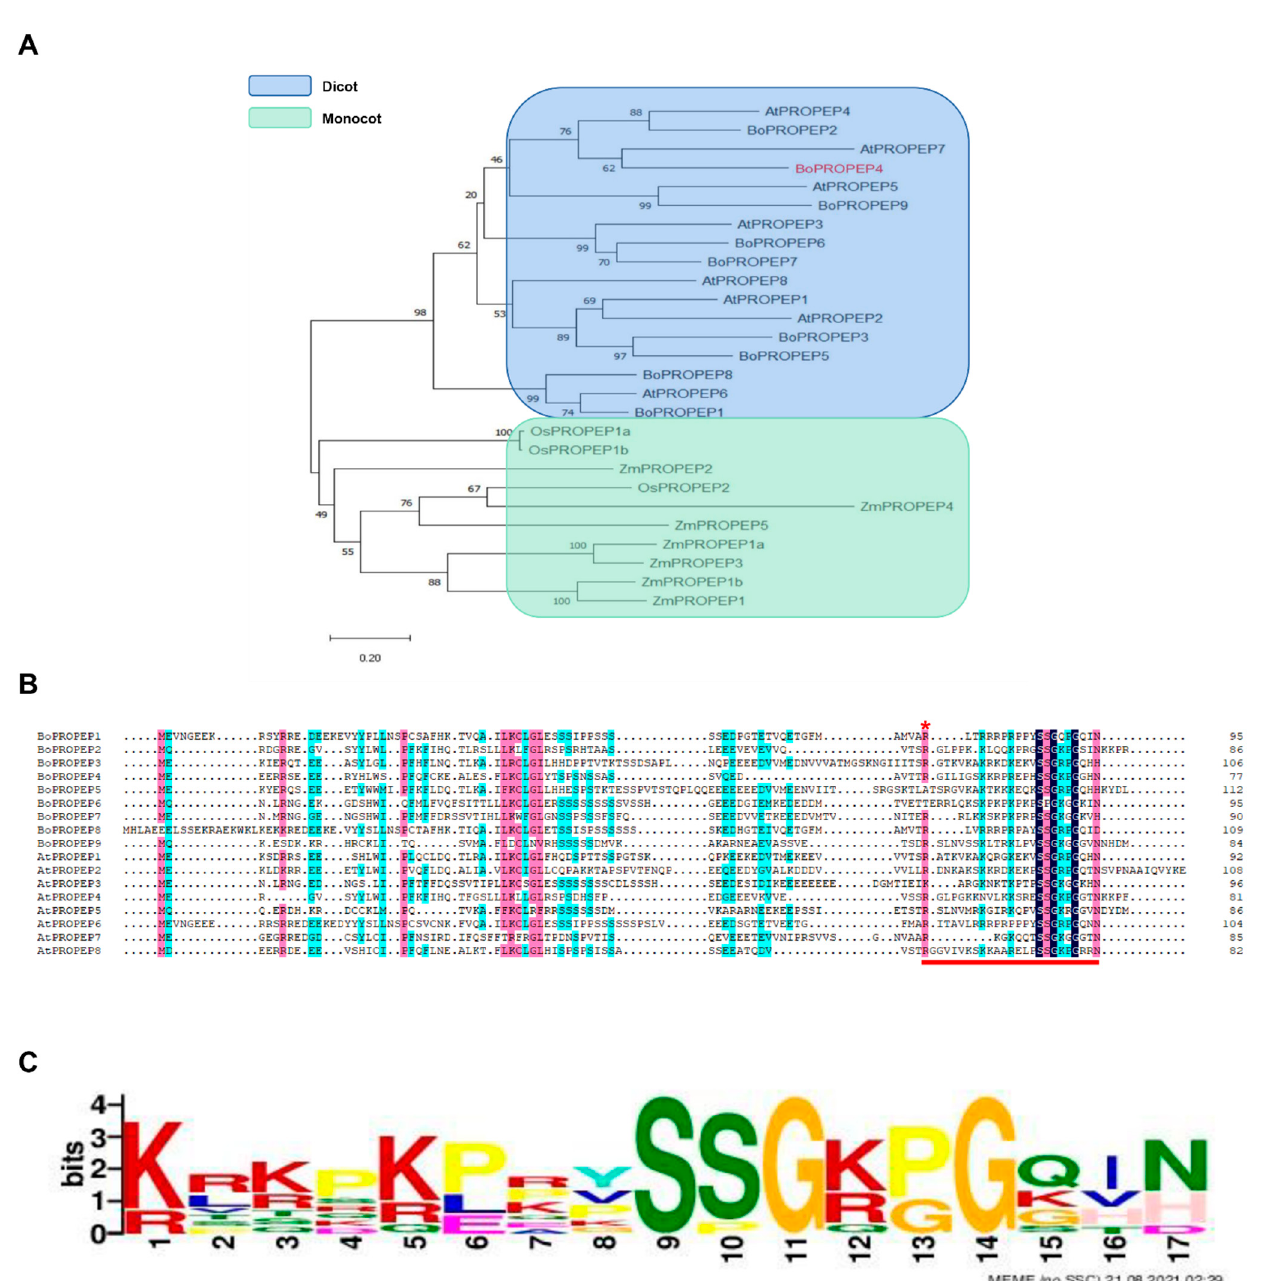
Figure 1. Identification and sequence analysis of BoPROPEP genes in broccoli. ( A ) Full-length amino-acid sequences of identified BoPROPEPs and published PROPEPs from other species were used to build a bootstrapped neighbor-joining tree. Major families are highlighted with colors according to the legend. BoPROPEP4 (red highlight) was mainly studied in this research. Scale-bar: amino-acid substitutions per site. ( B ) Alignment of nine BoPROPEPs and eight AtPROPEPs reveals conserved and divergent residues. Identical and similar residues are shaded in black, blue and pink. The conserved arginine (*) preceding the Pep sequence (indicated by the red line on the bottom) is highlighted with a red asterisk. ( C ) Depiction of the consensus sequences of aligned Pep sequences in broccoli using MEME tools.